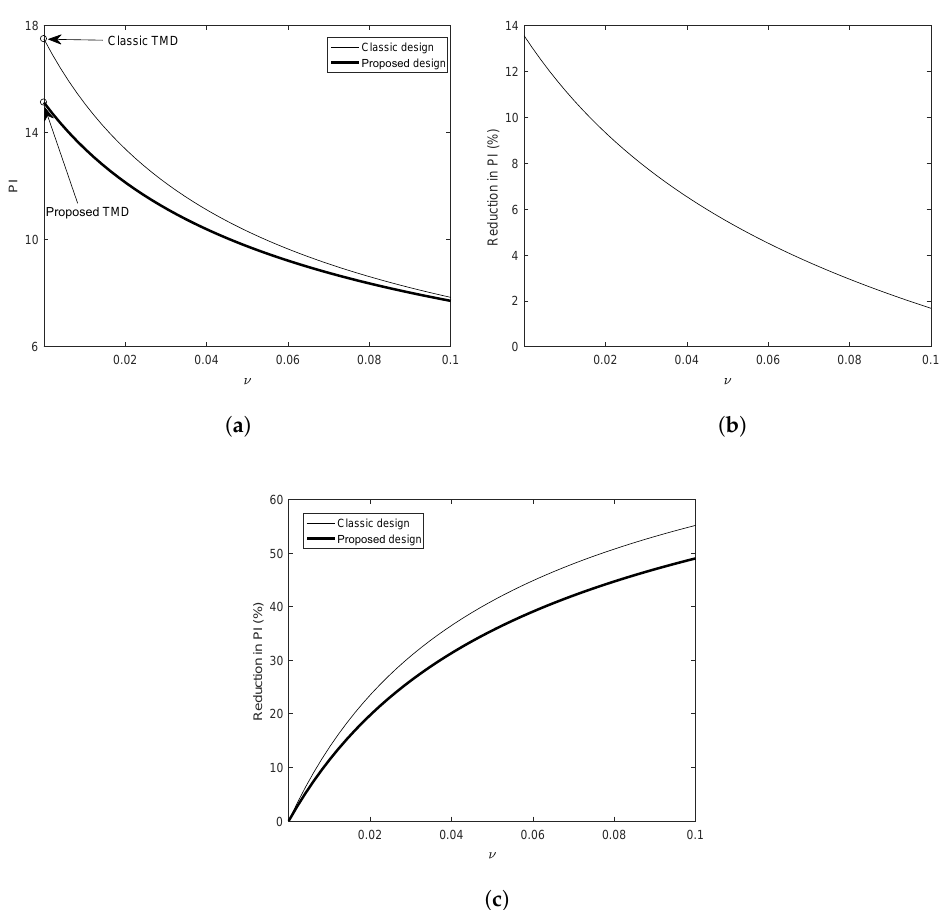
Figure 10. ( a ) Evolution of the performance index PI against the inertance-to-mass ratio ν for the set of parameters µ = 0.05 and β = 20%. Thin solid line: TMDI with classic design; thick solid line: TMDI with proposed design; circle markers: TMD with either classic or proposed design. ( b ) Evolution of the reduction in PI for the proposed TMDI compared to the classic TMDI. ( c ) Evolu- tion of the reduction in PI for the TMDI compared to the TMD. Thin line: classic design; thick line: proposed